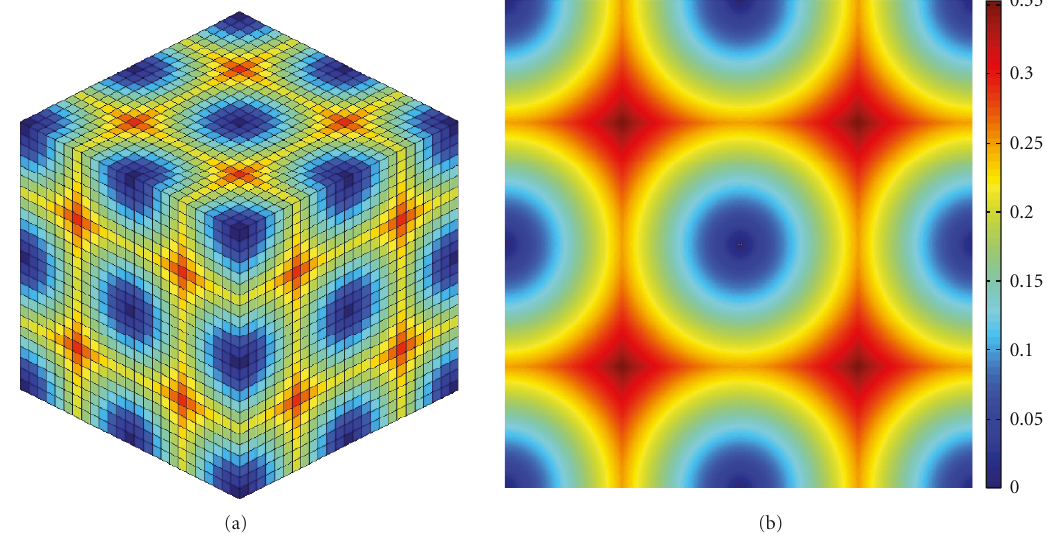
Figure 5: (a) A 3D plot representing the full OCV showing the expected type of geometric bias pattern, and (b) a 2D equivalent.